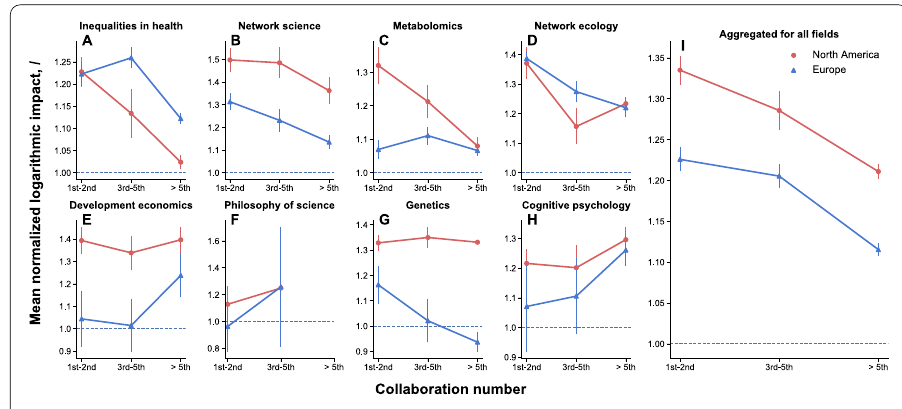
Figure 5 Evolution of impact with repeated collaborations. Mean normalized logarithmic impact of publications authored by a pair of prominent researchers (PR) as a function of the collaboration number (the number of times two prominent researchers have co-authored a paper: 1-2, 3-5, or >5; Methods). The normalized logarithmic impact I i of a paper i is the logarithmic number of citations (plus 1) log( k i + 1) of the paper divided by the mean of the logarithmic number of citations (plus 1) of papers with no prominent researcher collaboration in the same publication year (Methods). ( A ) inequalities in health, ( B ) network science, ( C ) network ecology, ( D ) metabolomics, ( E ) development economics, ( F ) philosophy of science, ( G ) genetics and ( H ) cognitive psychology. ( I ) Aggregated normalized logarithmic impact for all fields, as a function of the number of